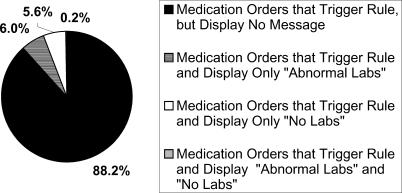
Medication Orders That Triggered Alerts